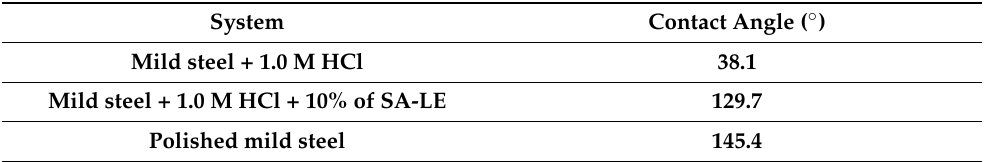
Figure 12. ( a ) Contact angle measurement on the polished mild steel surface, ( b ) contact angle measurement for the mild steel surface that is kept for 2 h in a 1.0 M HCl solution without inhibitor and ( c ) contact angle measurements on the mild steel surface that is kept for 2 h in a 1.0 M HCl solution containing 10% aqueous leaf extract of SA. Table 12. Contact angle values measured for different